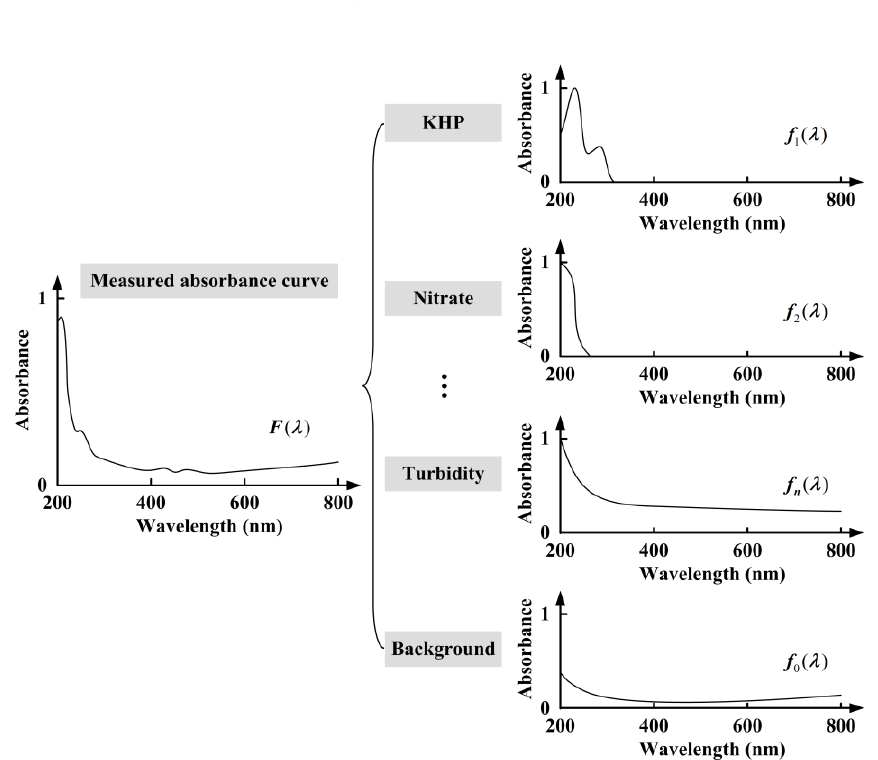
Figure 5. The decomposition strategy of the measured absorbance curve.